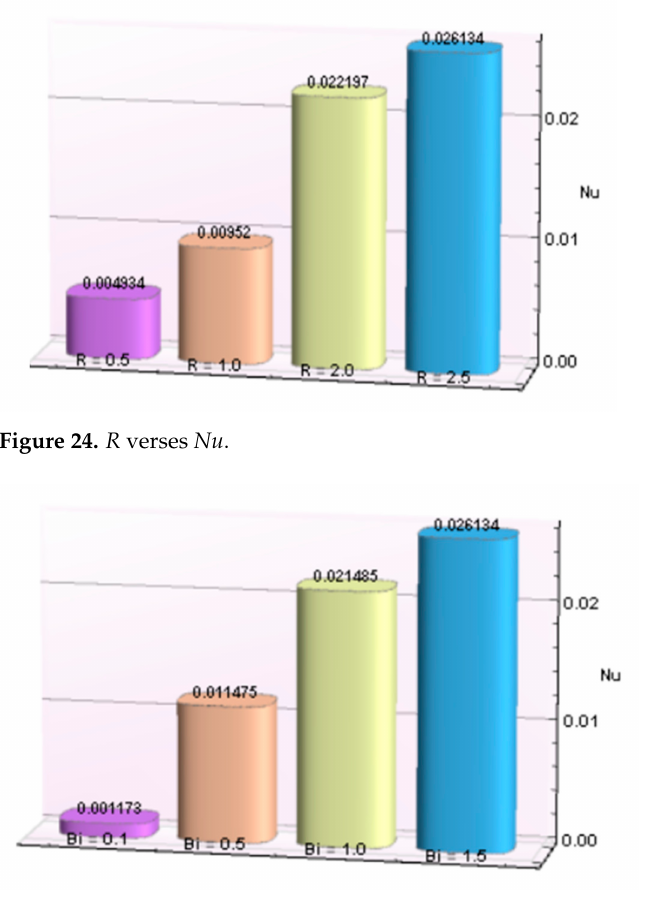
Figure 25. Bi verses Nu